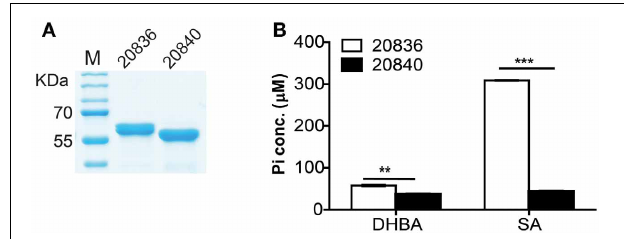
FIGURE 5 | Purity of the two AMP ligases (A) and their respective activities after 12min of incubation with 2, 3-DHBA or SA as enzyme substrates (B). AMP ligase reaction was assayed spectrophotometrically by coupling the formation of PPi (inorganic pyrophosphate) to the pyrophosphatase reactions. The substrate specificity of the two AMP ligases was tested by measuring the formation of inorganic phosphate (Pi). At each time point error bars represent standard errors of mean ( n = 3). ∗∗ P < 0 . 01, ∗∗∗ P < 0 . 0001.